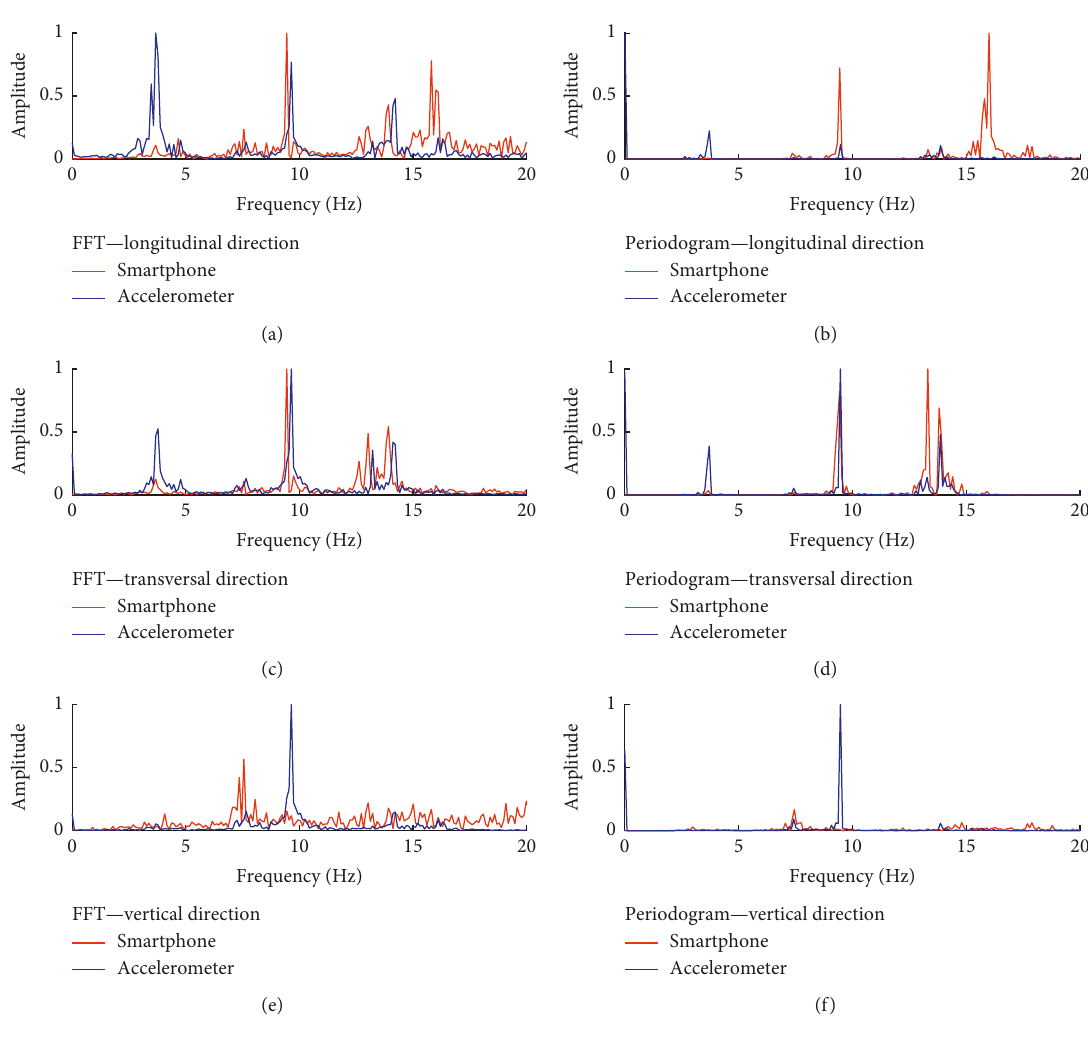
Figure 12: Dynamic frequencies in terms of FFT and